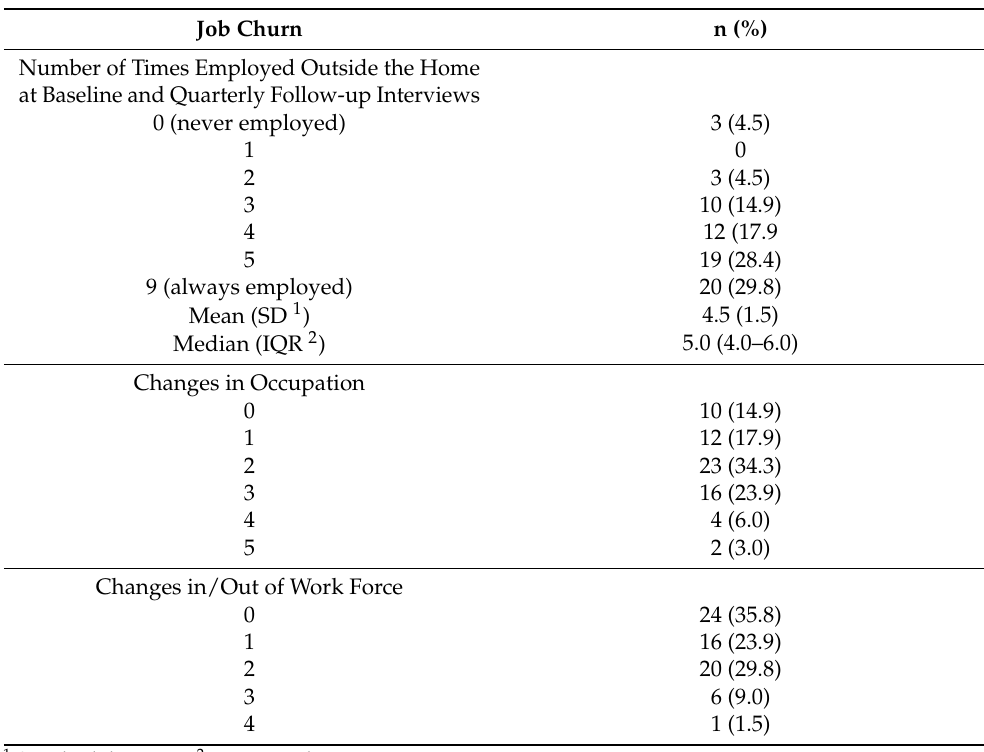
Table 2. Job Churn (Employment Changes) from Baseline to Follow-Up 5 Questionnaire, Latinx Women in Farmworker Families, North Carolina (N = 67). Job Churn n